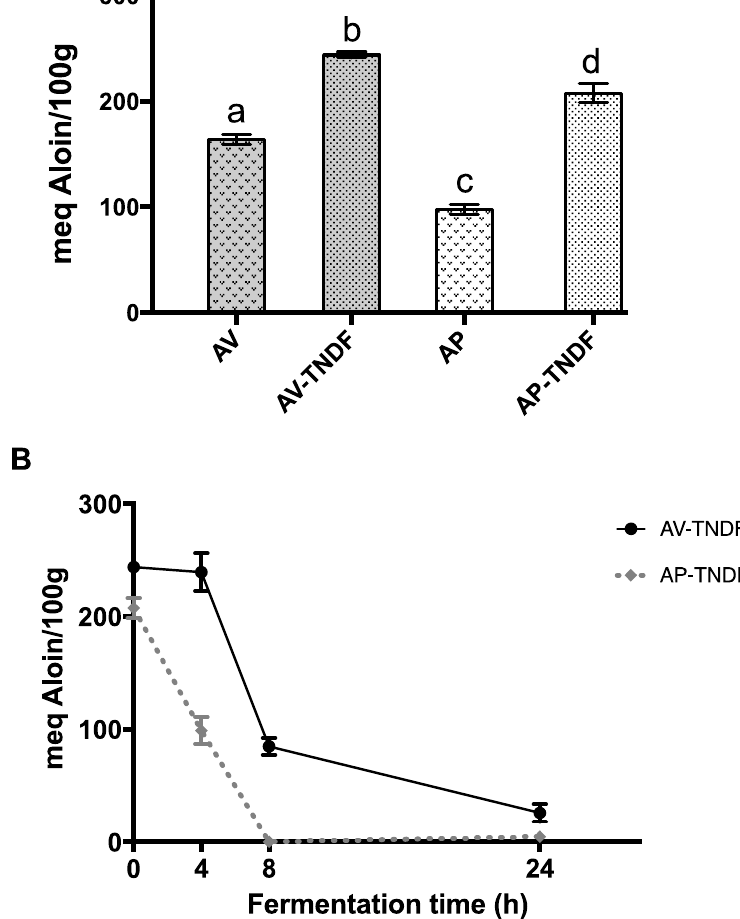
Figure 3. Total phenolic compounds. ( A ) Total phenolic compounds before and after digestion of Aloe vera gel (AV) and its polysaccharide extract (AP). Where AV and AP correspond to samples before digestion; AV-TNDF and AP-TNDF correspond to samples after digestion. ( B ) Changes in the total content of phenolic compounds during AV-TNDF and AP-TNDF fermentation.